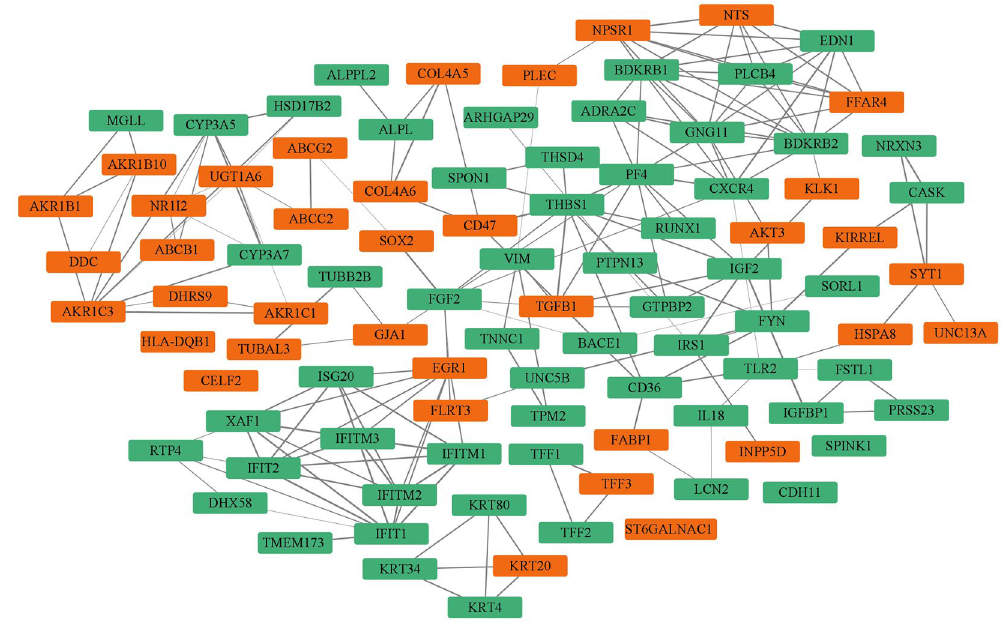
Figure 3. Protein–protein interaction (PPI) network of hub genes. The STRING network includes 95 nodes and 168 edges to represent 37 upregulated (Red rectangle) and 58 downregulated (Green rectangle) DEGs. The lines represent protein–protein interactions whereas the rectangles include the name of the